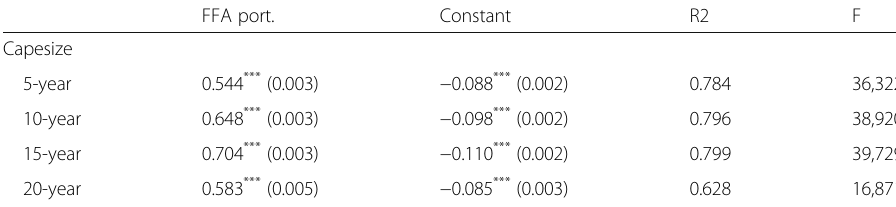
Table 8 Bootstrap results